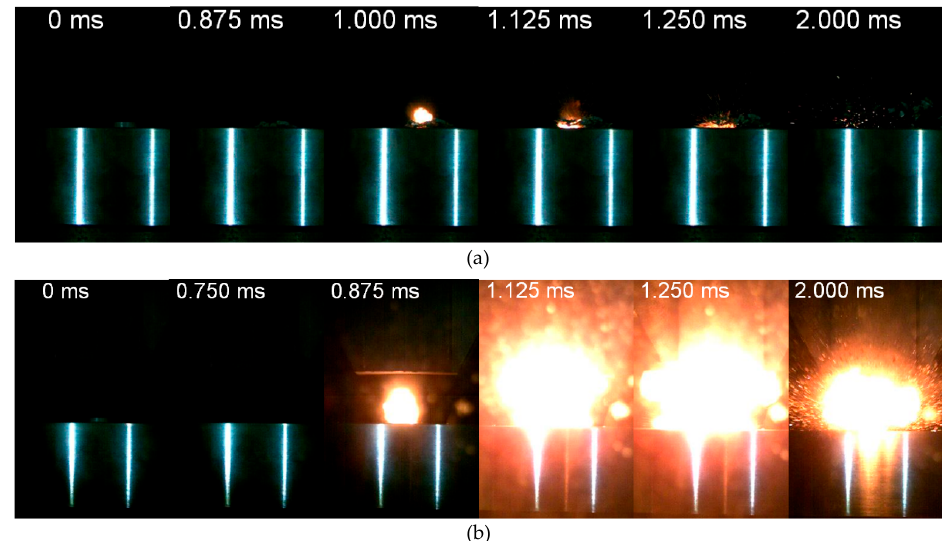
Figure 9. Impact response of HTSed type C and type E reactive material under the same drop height: ( a ) type C; ( b ) type